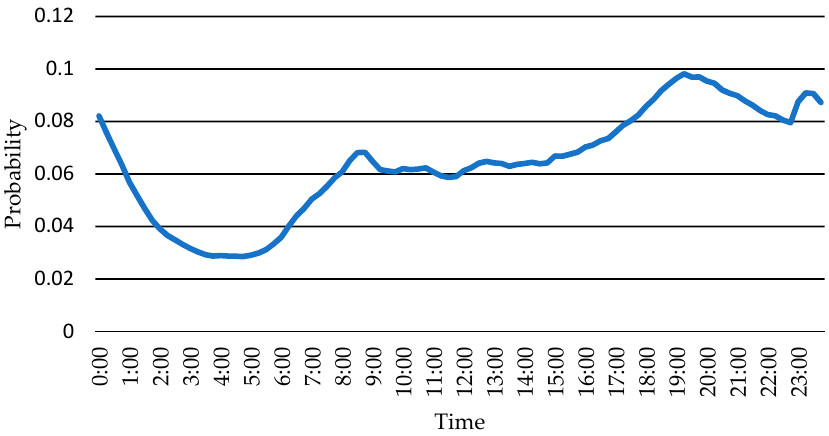
Figure 5. The estimated probability of the DC charger availability.